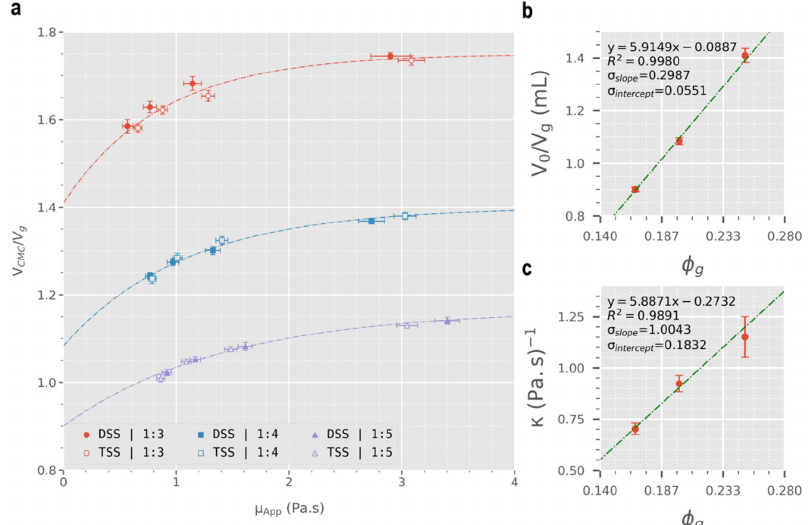
Figure 5. ( a ) CMC displacement per volume of foam-constituent-gas versus foam apparent viscosity ( µ app ). µ app was calculated using power-law indices obtained from the pipe viscometry experi- ments. Trendlines were obtained through curve fitting into an asymptotic regression model (see Equation (8)). Dotted lines represent flowrate isometric lines. ( b ) Linear regression of V 0 / V g against φ g ( p -value = 0.0288). ( c ) Linear regression of κ against φ g ( p -value =